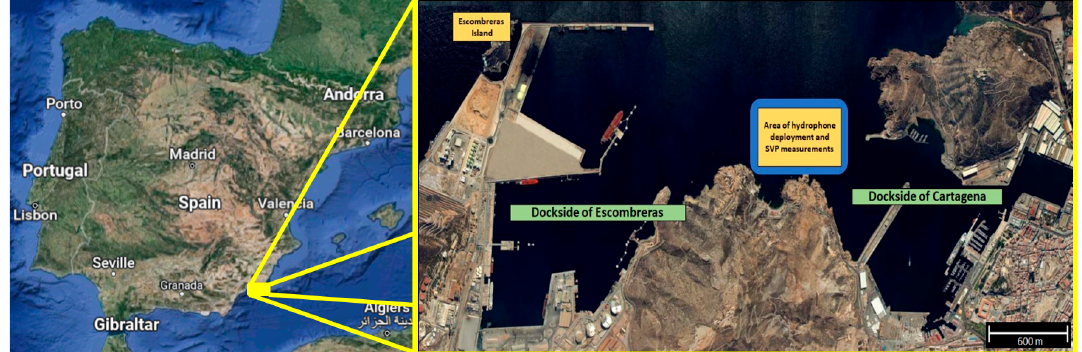
Figure 1. Study area: Cartagena Port (Mediterranean Sea). Dockside of Cartagena and Escombreras. The port of Cartagena is composed of two main docksides separated from each other and connected by road: one in Cartagena and the other in Escombreras. Located on the dockside of Cartagena is the terminal for cruiser, fishing, recreative, container and general merchant ships. Located on the dockside of Escombreras are the terminals for oil tankers, gas–oil, and other general merchant ships. The total numbers of large ships in the port during the years 2013, 2014 and 2015 were 1832, 1858 and 1957, respectively, and the total number of megatons of merchandise traffic were 29,511, 32,522 and 32,670, respectively